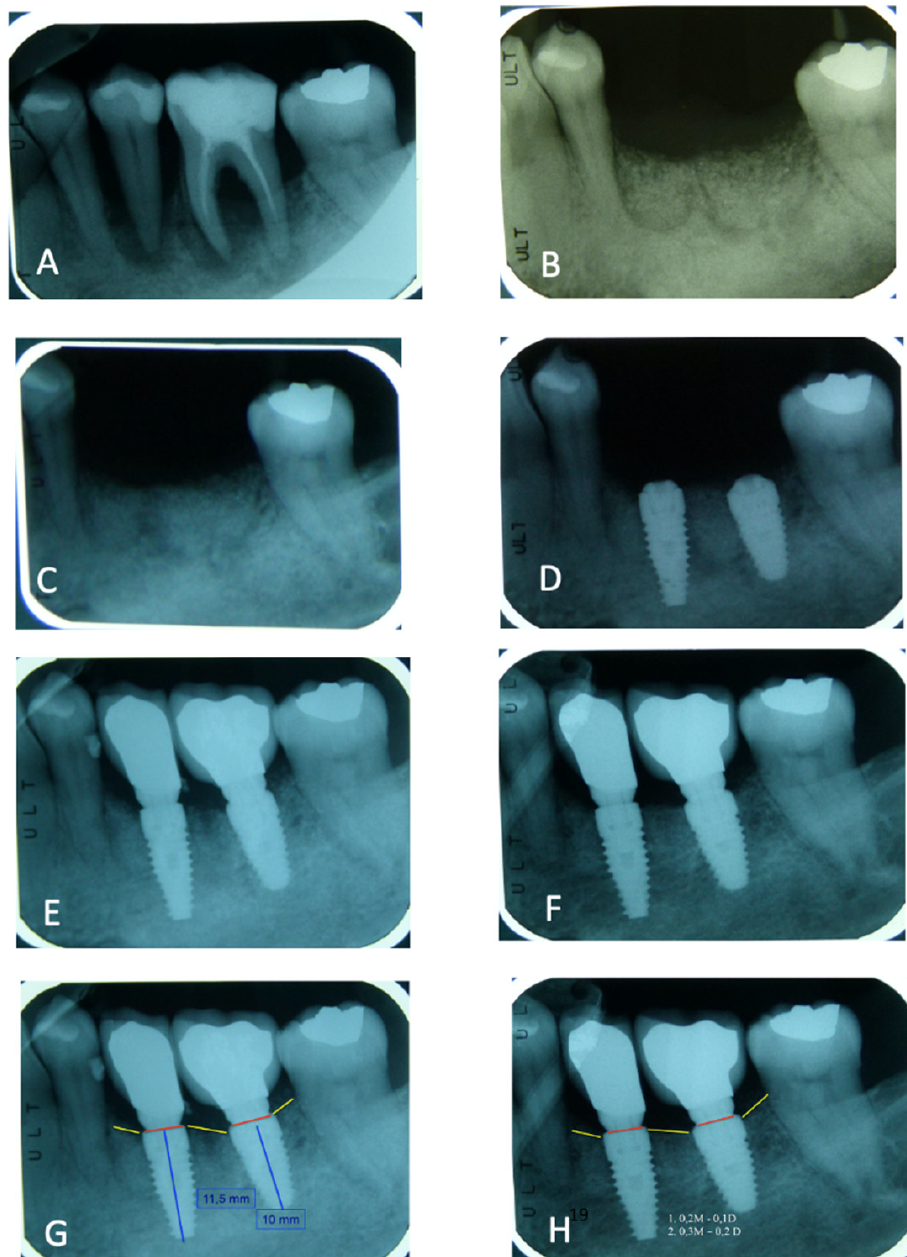
Figure 5. ( A ) Elements 3.5 and 3.6 before the extractions—( B ). ASP immediately after the surgery— ( C ). Radiographic control after 3 months—( D ). Implant insertion after 4 months—( E ). Image after the prosthetic load—( F ). Image after 1 year of load—( G ). Bone level around dental implants after the load—( H ). Average mesial-distal and total bone loss value were detected after one year of